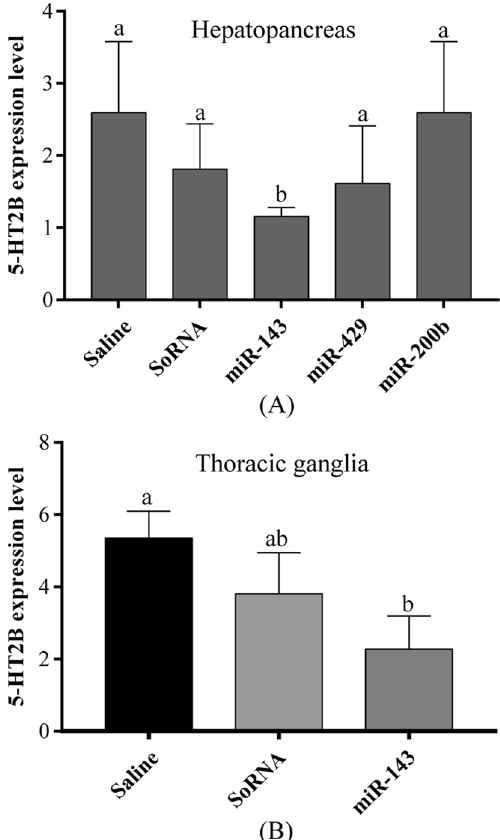
Figure 4. ( A ) Co-culture of the hepatopancreas with different miRNA mimics affects the expression level of the 5-HT2B receptor; ( B ) co-culture of the thoracic ganglion with an miR-143 mimic affects the expression level of the 5-HT2B receptor. Different letters above the horizontal line indicate significant differences between two groups ( P <